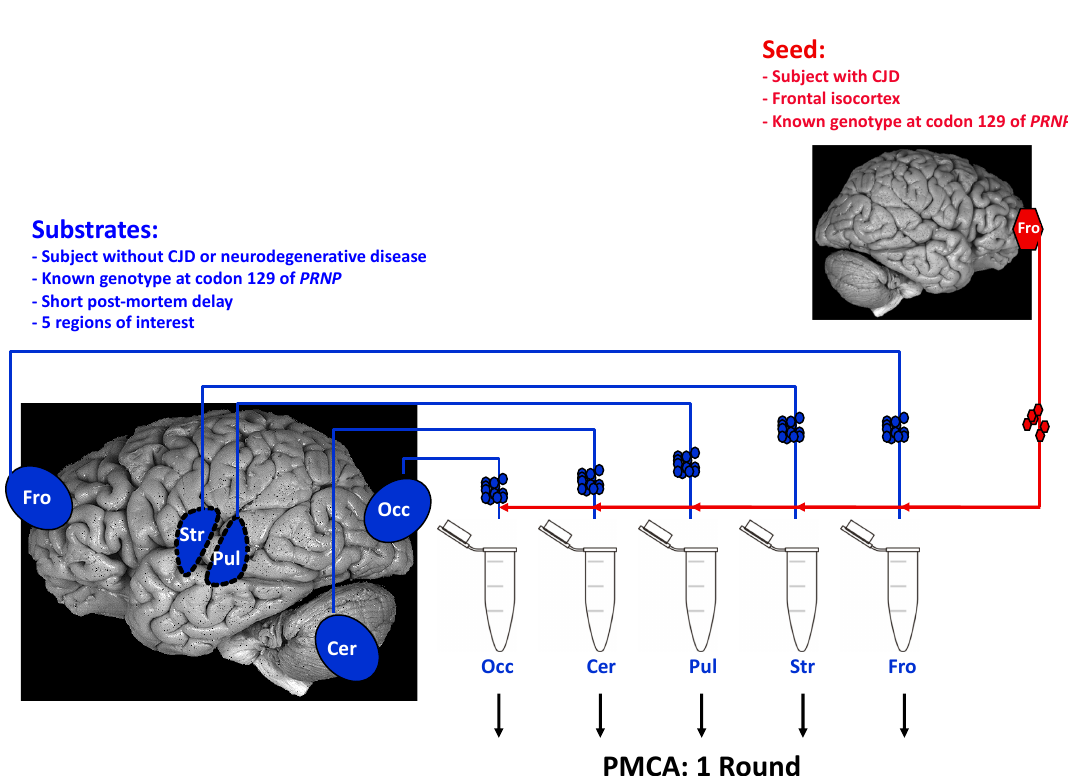
Scheme 2. Modeling of region-specific targeting observed in Creutzfeldt-Jakob disease rsPMCA setup is based on standard PMCA parameters (one round only). It uses, as substrates, key brain regions that are known to be differentially affected by PrPsc deposition in various human prion disorders and scrapie experimental models. In humans, tissues were selected on the basis of the availability of autopsy-obtained frozen brain material. In this illustration, a set of five cerebral regions is used to prepare PMCA substrates: frontal isocortex (Fro), occipital isocortex (Occ), striatum (Str), pulvinar (Pul), and cerebellar cortex (Cer). CJD: Creutzfeldt-Jakob Disease.